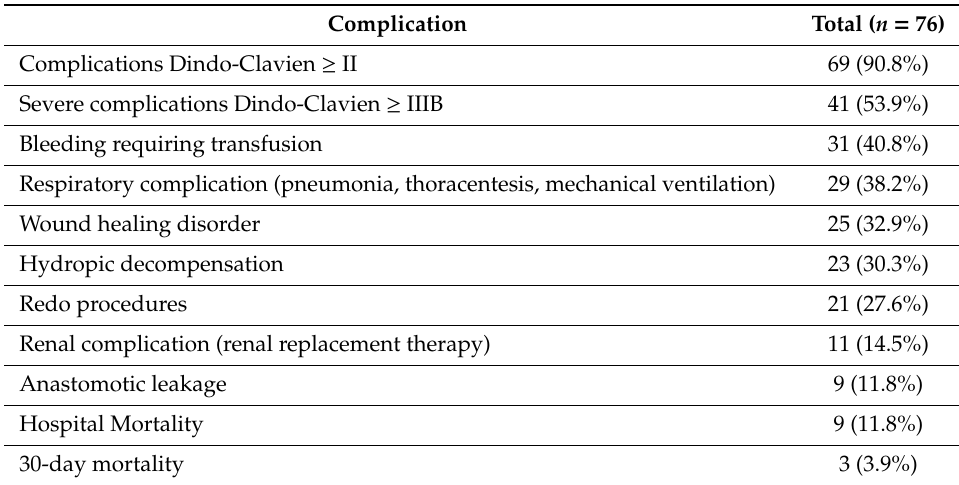
Table 2. Morbidity and mortality.